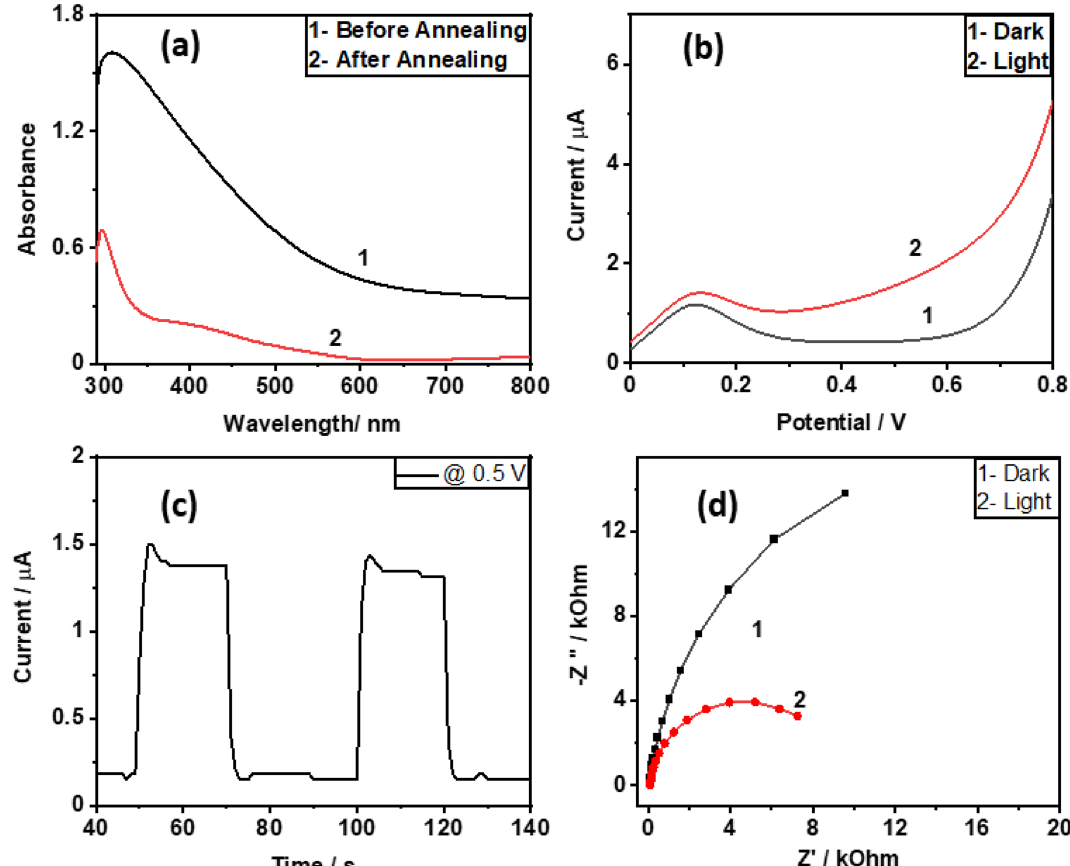
Figure 4. ( a ) UV–Vis spectra of α-Fe 2 O 3 before (1) and after (2) annealing, ( b ) linear sweep voltammetry curve under dark (1) and light (2) conditions c) Chronoamperometric curve of α-Fe 2 O 3 under the light on–off conditions at 0.5 V potential and d) Nyquist plot under the dark (1) and light (2) condition at in 0.5 M NaOH 0.1 Hz to 10 kHz frequency range and 5 mV AC RMS amplitude. The area of the exposed electrode is 1.5 cm 2